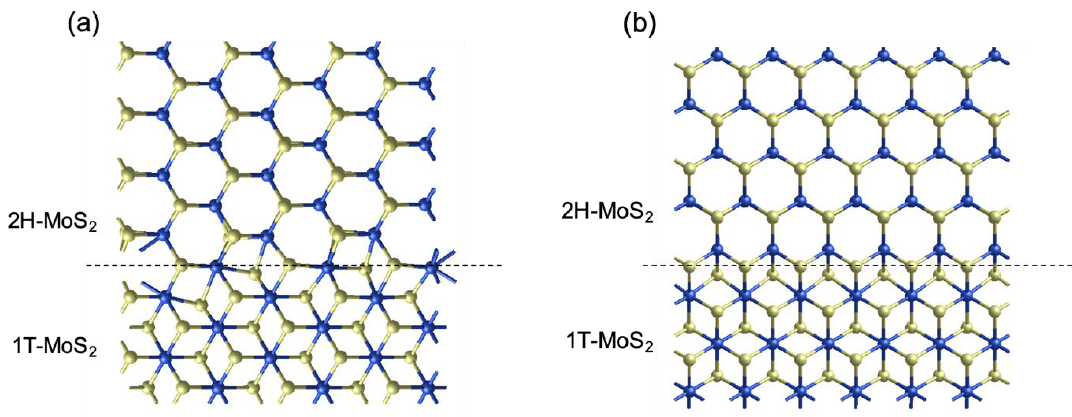
Figure 9. Top views of the relaxed atomic configurations of lateral 1T-MoS 2 /2H-MoS 2 interface models with ( a ) armchair and ( b ) zigzag edge contacts. Blue and yellow spheres correspond to Mo and S atoms, respectively.